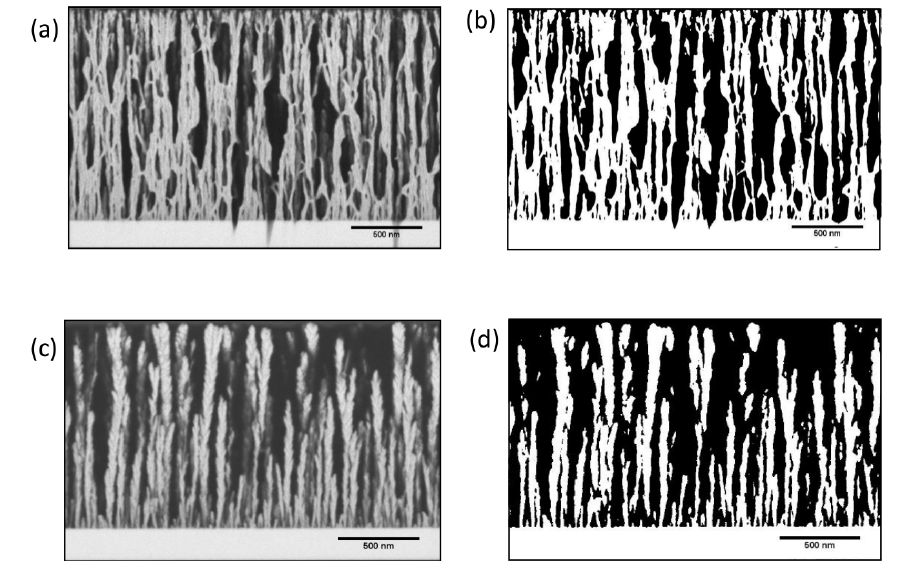
Figure 8. Highly resolved SEM images and binarizations of the absorption layers. Pixel edge lengths 3nm. (a) Sample Ta80. (b) Binarization of (a) . (c) Sample Ta85. (d) Binarization of (c) . The tantalum component of Ta80 appears thinner than that of sample Ta85. Moreover, pores in Ta85 grow bottom up.